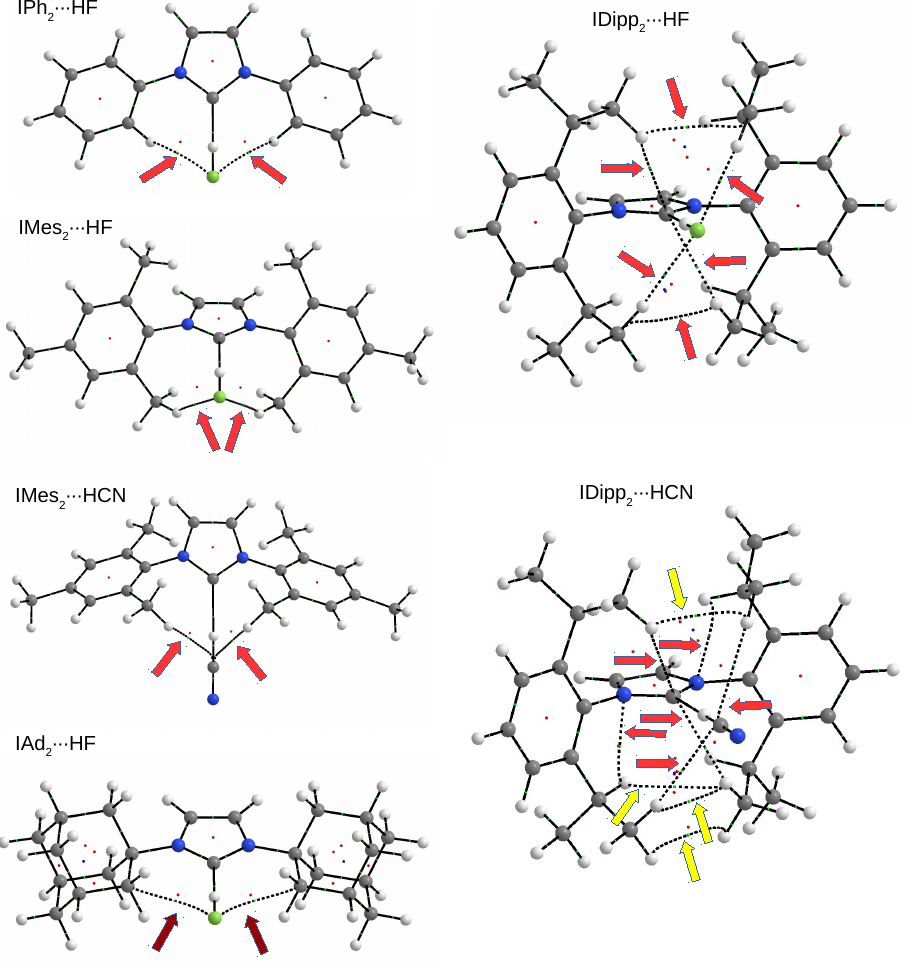
Figure 6. Molecular graphs of selected IR 2 · · · HF and IR 2 · · · HCN dimers. Arrows show the presence of bond paths for some accompanying interatomic interactions (hydrogen bonds—red, tetrel bonds— brown, and C-H · · · H-C contacts—yellow). Large balls represent atoms (hydrogen—white, carbon— gray, nitrogen—blue, and fluorine—light green) and small balls represent critical points (bond critical points—light green, ring critical points—red, and cage critical